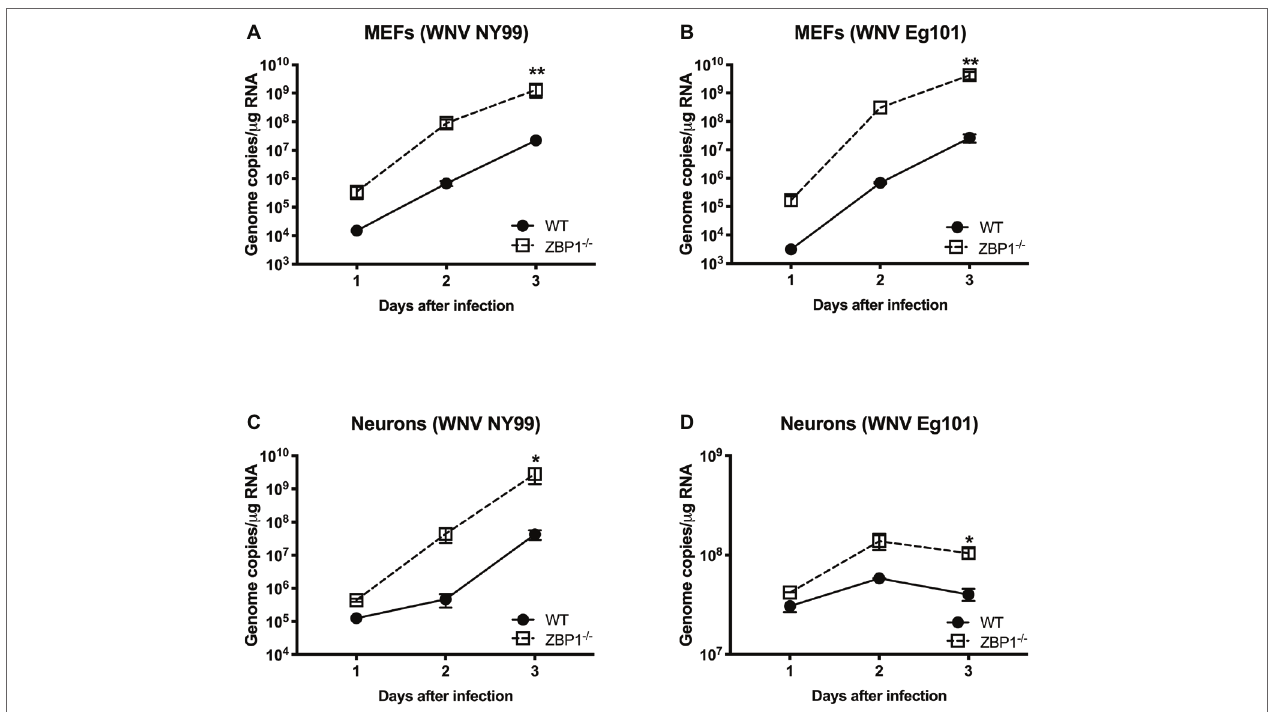
FIGURE 6 | Analysis of viral RNA levels in the primary cells isolated from WT and ZBP1 −/− mice. (A–D) Cells were infected with WNV NY99 or Eg101 and total RNA extracted from cell lysates was used to conduct qRT-PCR to measure WNV RNA (expressed as genome copies/μg of RNA). Error bars represent SEM (three independent experiments conducted in duplicate), * p < 0.05, ** p < 0.001.